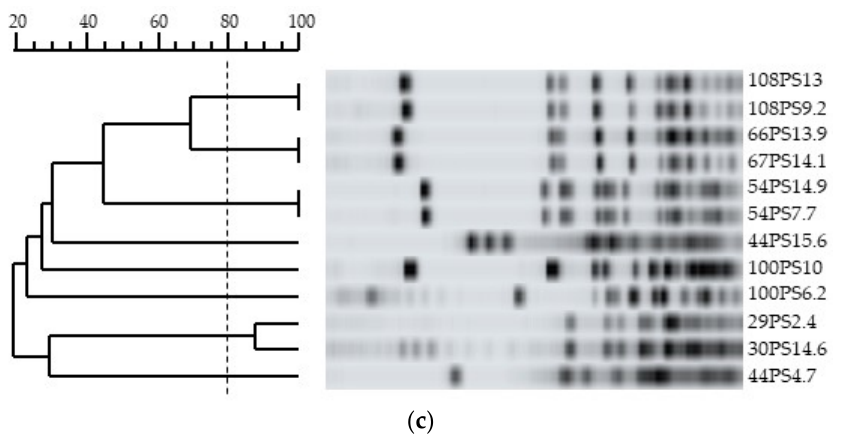
Figure 1. PFGE analysis of B. breve ( a ), B. longum subsp. longum ( b ) and B. pseudocatenulatum ( c ) strains. Clonally related strains share 80% of common bands (dotted line).